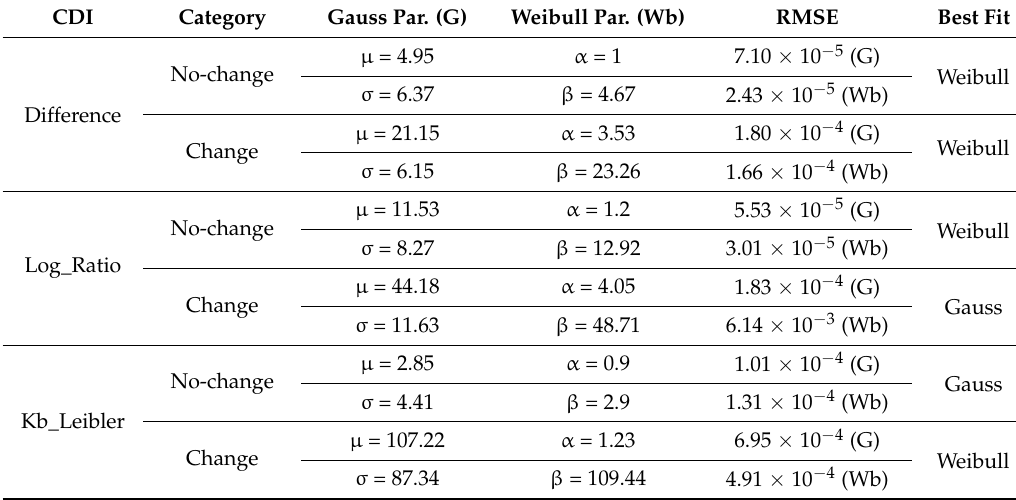
Table 5. DS1, PDF